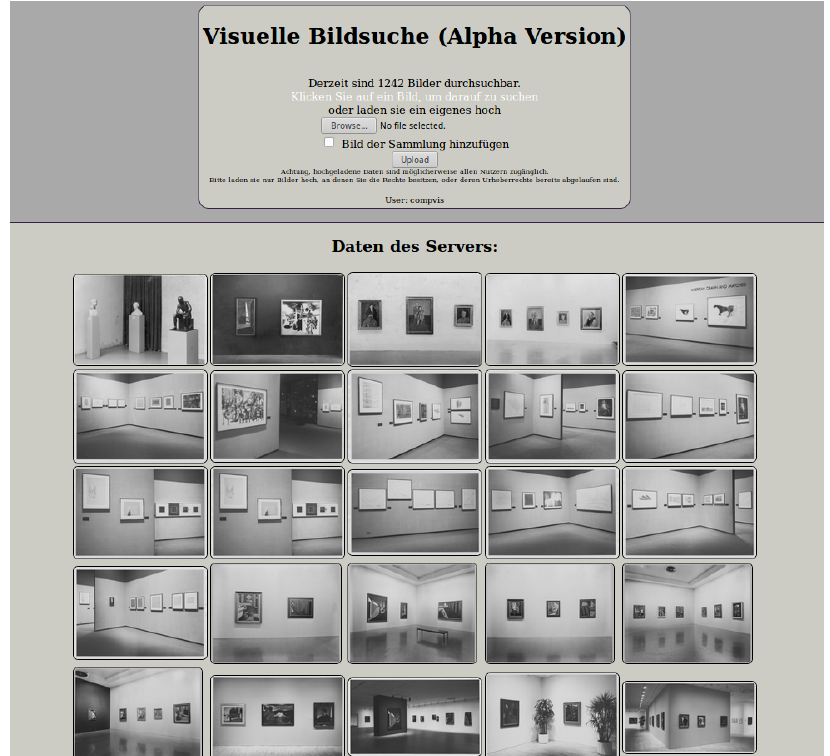
Figure 5. The interface for visual search holds a collection of exhibition photographs as released by the Museum of Modern Art, New York. As expressed in the top region of the interface, at this point, in order to select a search region, users can either click on an existing image or upload a new one to the collection. Image rights: Computer Vision Group, Heidelberg University. Displayed photographs/details belong to the Museum of Modern Art, New